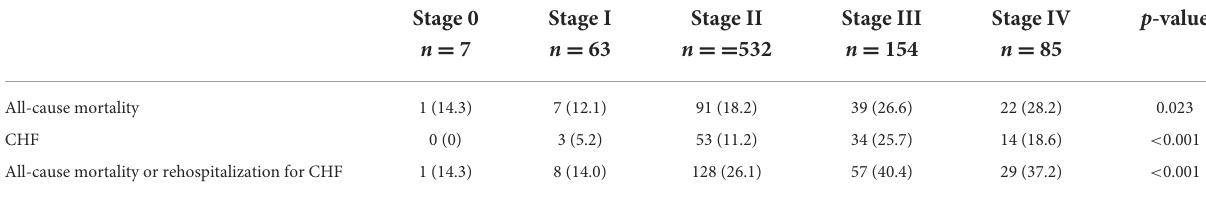
TABLE 3 Two-year outcome according to stage of cardiac